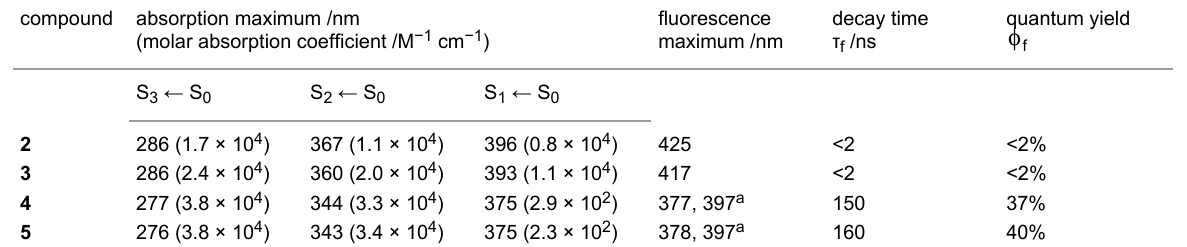
Table 1: UV–vis absorption and emission data for pyrene–adenine conjugates 2 – 5 measured in diluted dichloromethane solution at ambient tempera- ture.